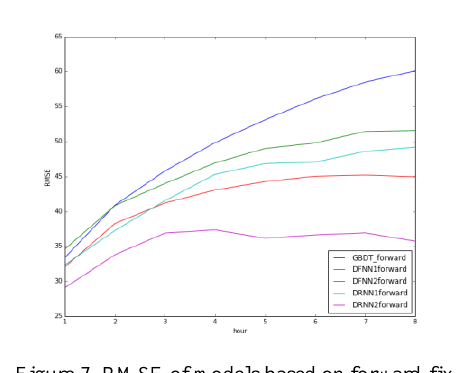
Figure 7. RMSE of models based on forward-fix